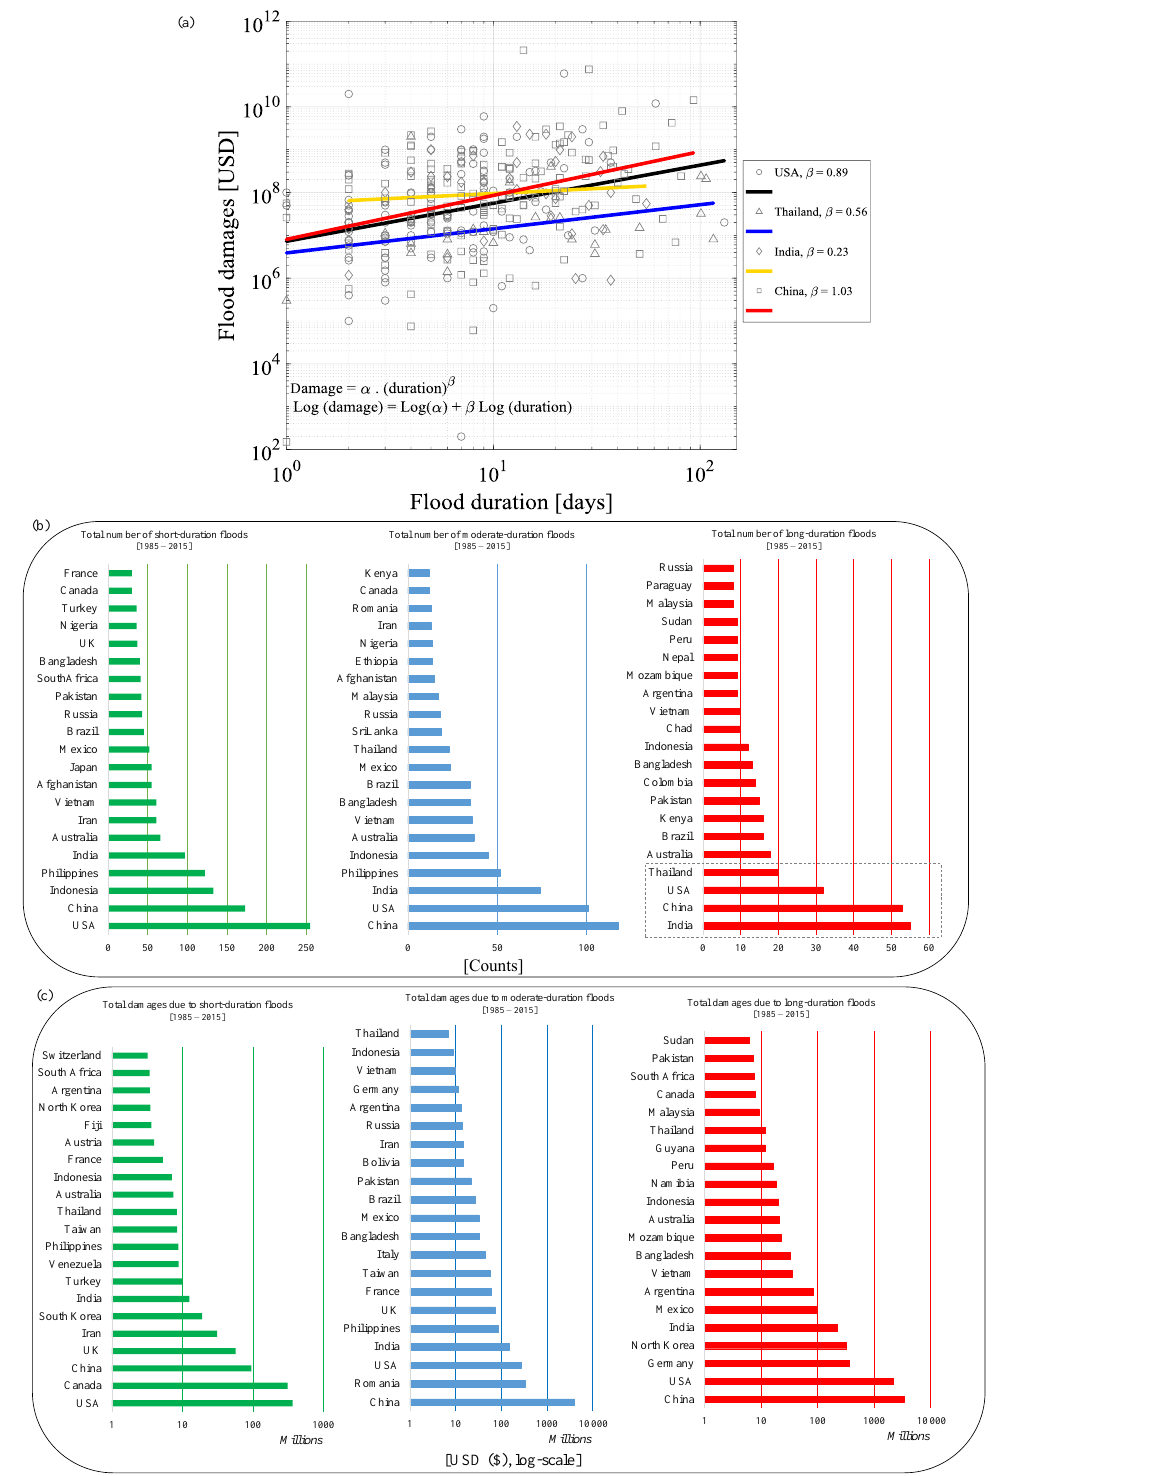
Figure 8. (a) Covariation of flood duration with the corresponding flood damages for the top four countries with the maximum number of long-duration flood events (i.e., India, China, the United States, and Thailand), (b) total number of short- (less than 7 days), moderate- (8 to 20 days), and long-duration (21 days and above) floods, and (c) total damages due to short-, moderate-, and long-duration floods. These countries are the top 21 countries, which are ranked based on the frequency of each flood duration category and corresponding flood damages using the DFO flood data from 1985 to